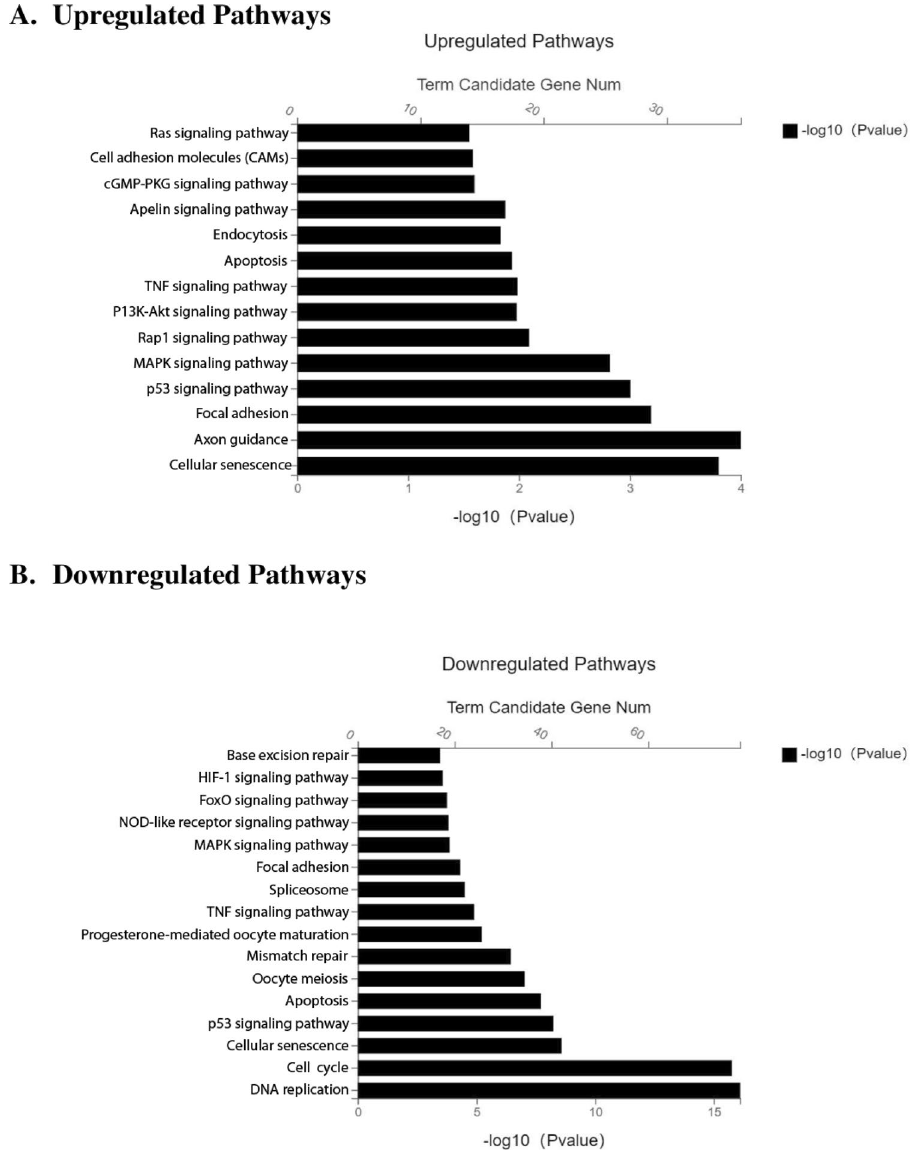
Figure 4. Bioinformatics analysis of the functional pathways contributing to radioresistance in EMT6 RR_MJI cells. List of top 10 significant molecular pathways determined by KEGG pathway analysis as described by Kaneisha et al. 19 for all 418 upregulated genes ( A ) and 430 downregulated genes ( B ) in EMT6 RR_MJI